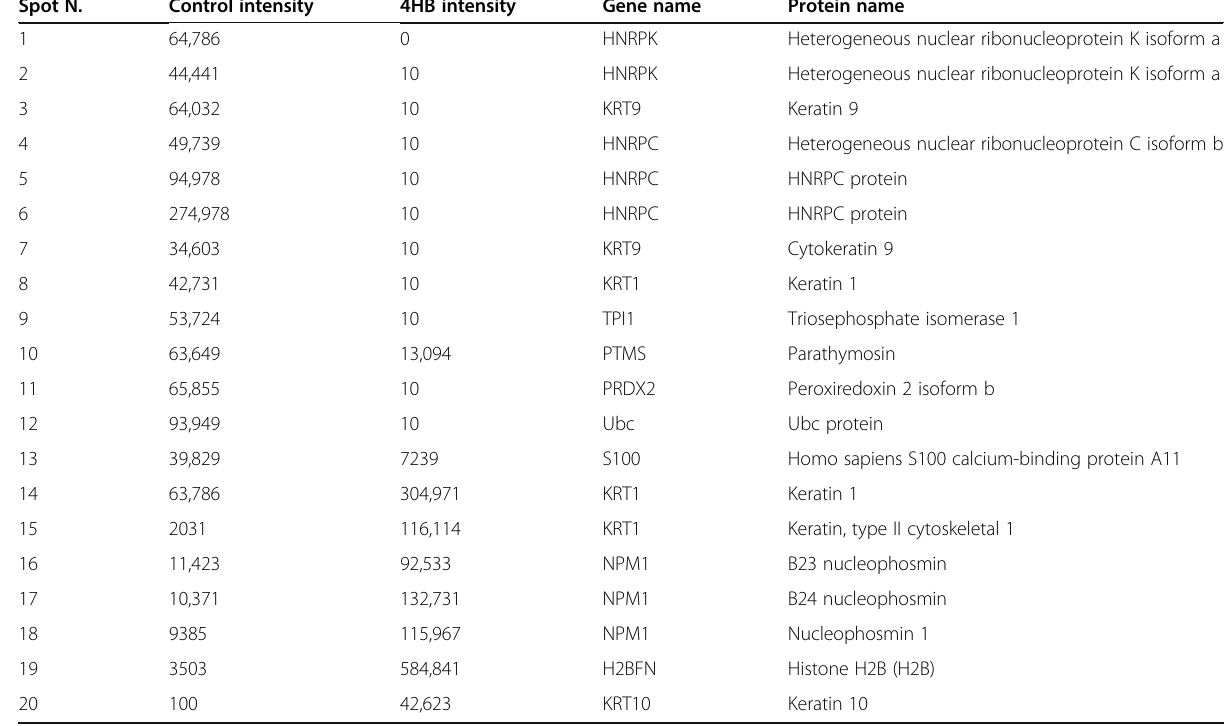
Table 1 The results of two-dimensional electrophoresis and Q-tof Spot